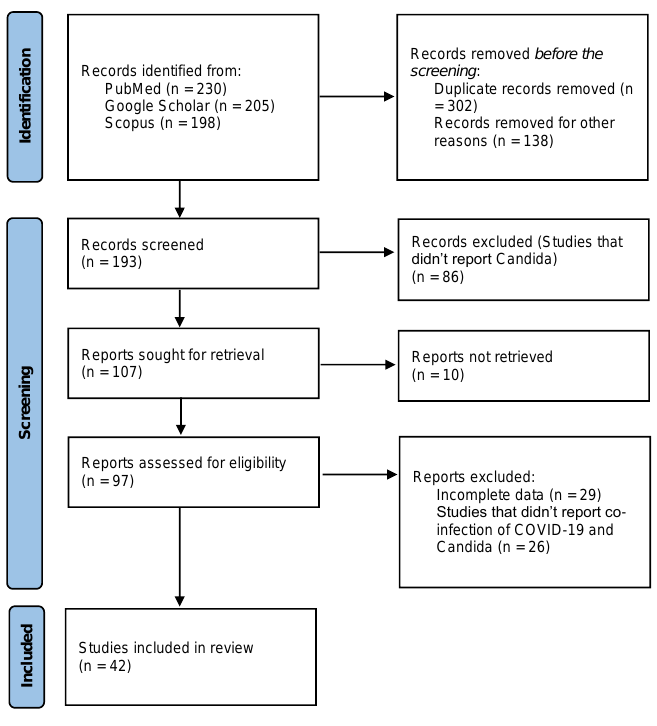
Figure 1. PRISMA